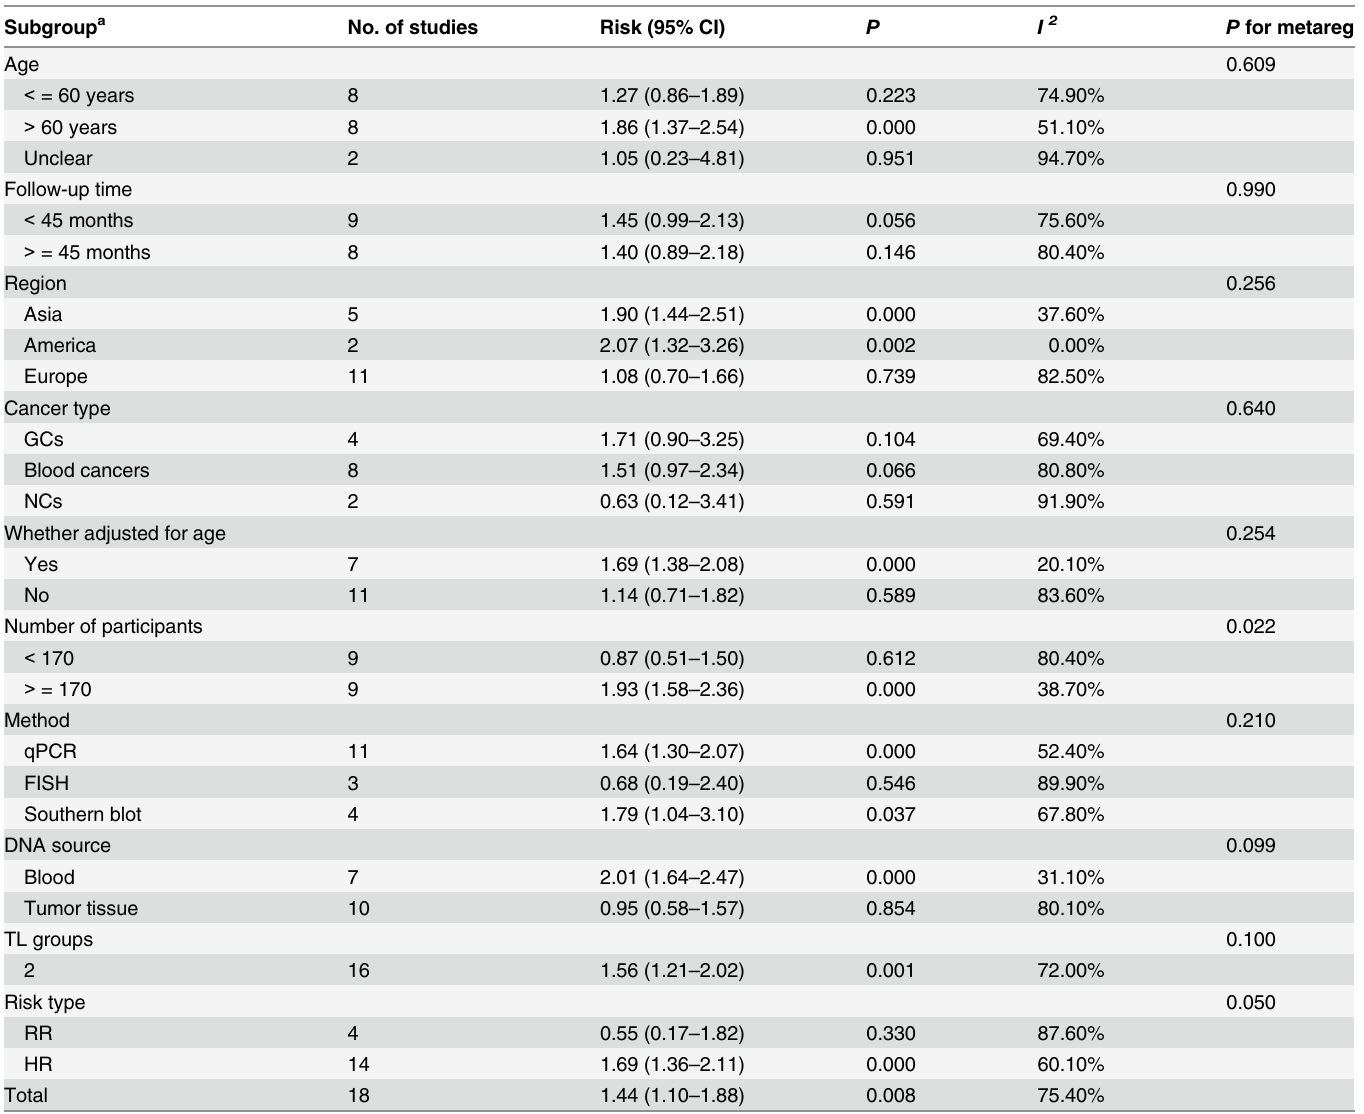
Table 3. Subgroup analysis of telomere length and cancer